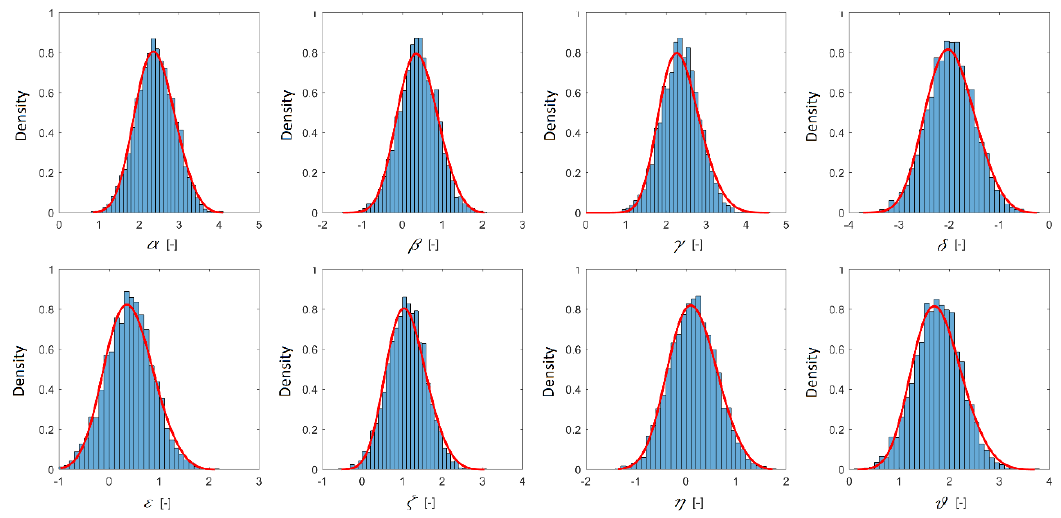
Figure 6. Histograms of NDWI m parameters and GEV PDF.